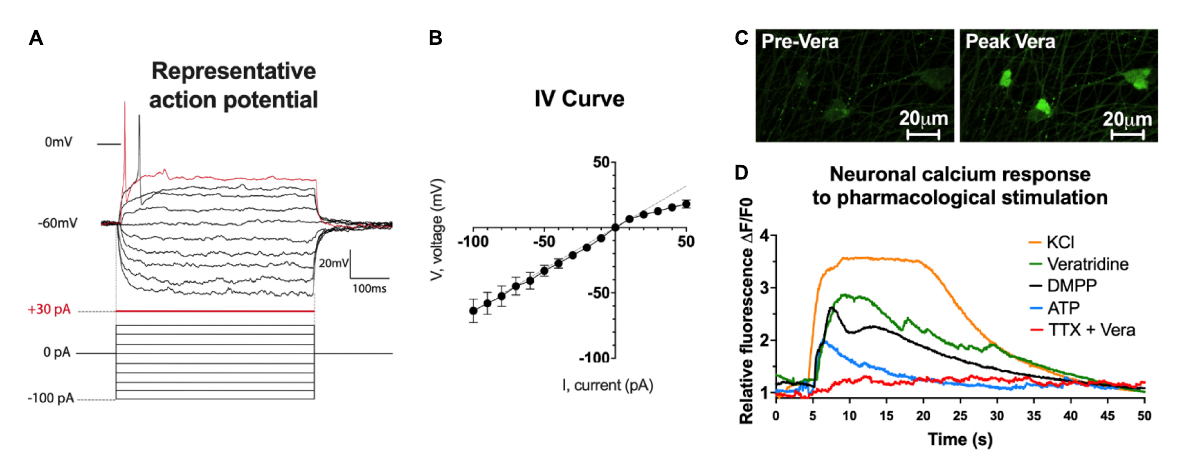
FIGURE4 Functional characterization of enteric neurons. (A) Raw traces show individual voltage responses to series of 500 ms current applied at 0.1Hz, with steps of 10 pA until neuron firing. (B) Average steady-state I/V relationship of recorded enteric neurons (15 neurons analyzed from n = 5 cultures from 5 independent rat embryos). (C,D) Fluorescence images (C) and representative plot of Ca 2 + response (D) evoked by 75 mM KCl, 10 µ M DMPP, 100 µ M BzATP, 30 µ M veratridine and 30 µ M veratridine + 0.5 µ M TTX (44 neurons analyzed from n = 4 cultures from 4 independent rat